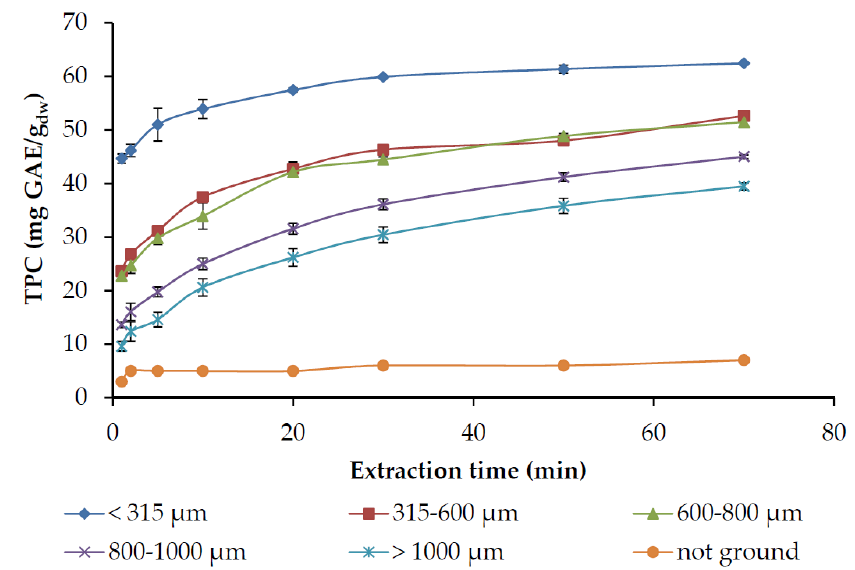
Figure 8. The influence of grinding to di ff erent particle sizes on the total phenols recovery (TPC) by 80% acetone in water solution, at 22 ◦ C, and solid-to-liquid ratio of 1:20 g / mL. Table 4. The e ff ect of grinding to di ff erent particle size, maceration at di ff erent duration, or maceration combined with Pulsed Electric Field (PEF) on the extraction model parameters, total phenolic content (TPC), antiradical capacity, and